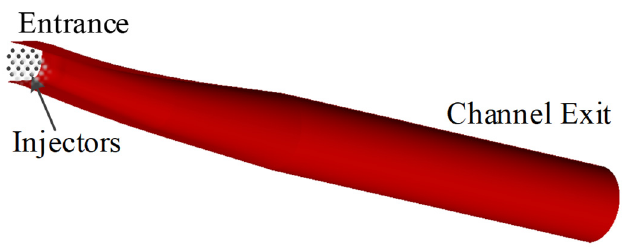
Figure 3. Half-model of turbine inlet channel from the TBCC inlet.